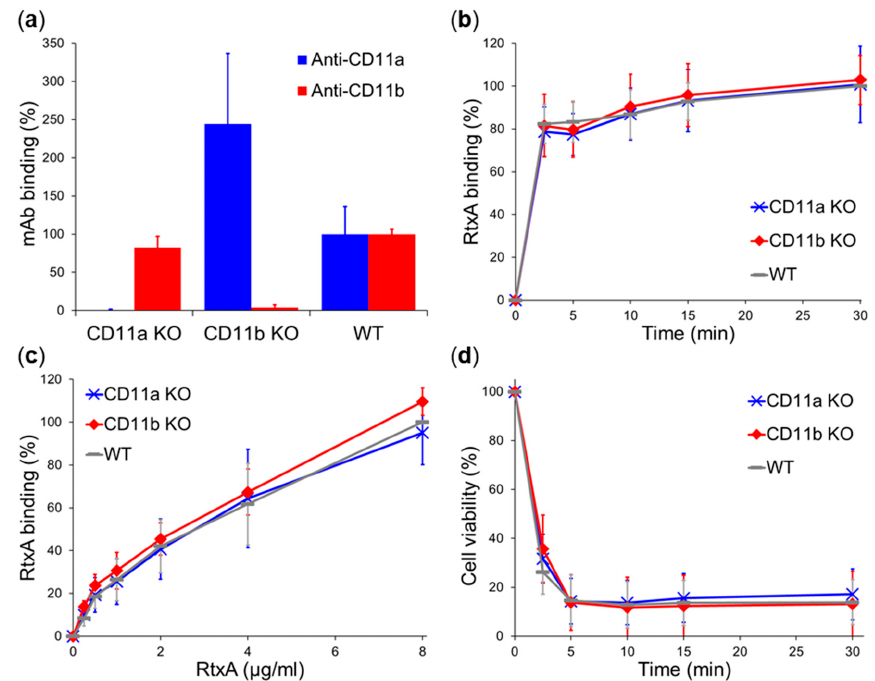
Figure 5. RtxA binds and kills CD11a KO and CD11b KO macrophages with the same efficacy as WT macrophages. ( a ) CD11a KO, CD11b KO, and control WT mouse macrophages (1 × 10 6 / mL) were incubated for 30 min at 4 ◦ C with anti-CD11a and anti-CD11b mAbs and analyzed by flow cytometry. Binding data were deduced from the MFI values and expressed as percentage of mAb binding to WT macrophages (taken as 100%). ( b ) CD11a KO, CD11b KO, and WT macrophages (1 × 10 6 / mL) were incubated with 2 µ g / mL of the purified and labeled RtxA-Dy495 toxin for di ff erent times at 4 ◦ C and analyzed by flow cytometry. ( c ) CD11a KO, CD11b KO, and WT macrophages (1 × 10 6 / mL) were incubated with di ff erent concentrations of RtxA-Dy495 for 30 min at 4 ◦ C and analyzed by flow cytometry. ( b , c ) Binding data were deduced from the MFI values and expressed as percentage of RtxA binding to WT macrophages at time 30 min ( b ) or at a concentration of 8 µ g / mL ( c ) (taken as 100%). Each point represents the mean value ± SD of at least three independent experiments. RtxA binding to CD11a KO and CD11b KO macrophages was at all measured time and concentration points statistically indistinguishable from binding to WT macrophages ( p -value > 0.05; ANOVA). ( d ) CD11a KO, CD11b KO, and WT macrophages (1 × 10 6 / mL) were incubated with 0.5 µ g / mL of RtxA for di ff erent times at 37 ◦ C. Cell viability was determined by a cell viability staining assay using 1 µ g / mL of Hoechst 33258 followed by flow cytometry. The viability of cells incubated without RtxA (time 0) was taken as 100%. Each point represents the mean value ± SD of at least five independent experiments. Upon incubation with RtxA, the viability of CD11a KO and CD11b KO macrophages was at all measured time points found to be statistically the same as the viability of WT macrophages ( p -value > 0.05;